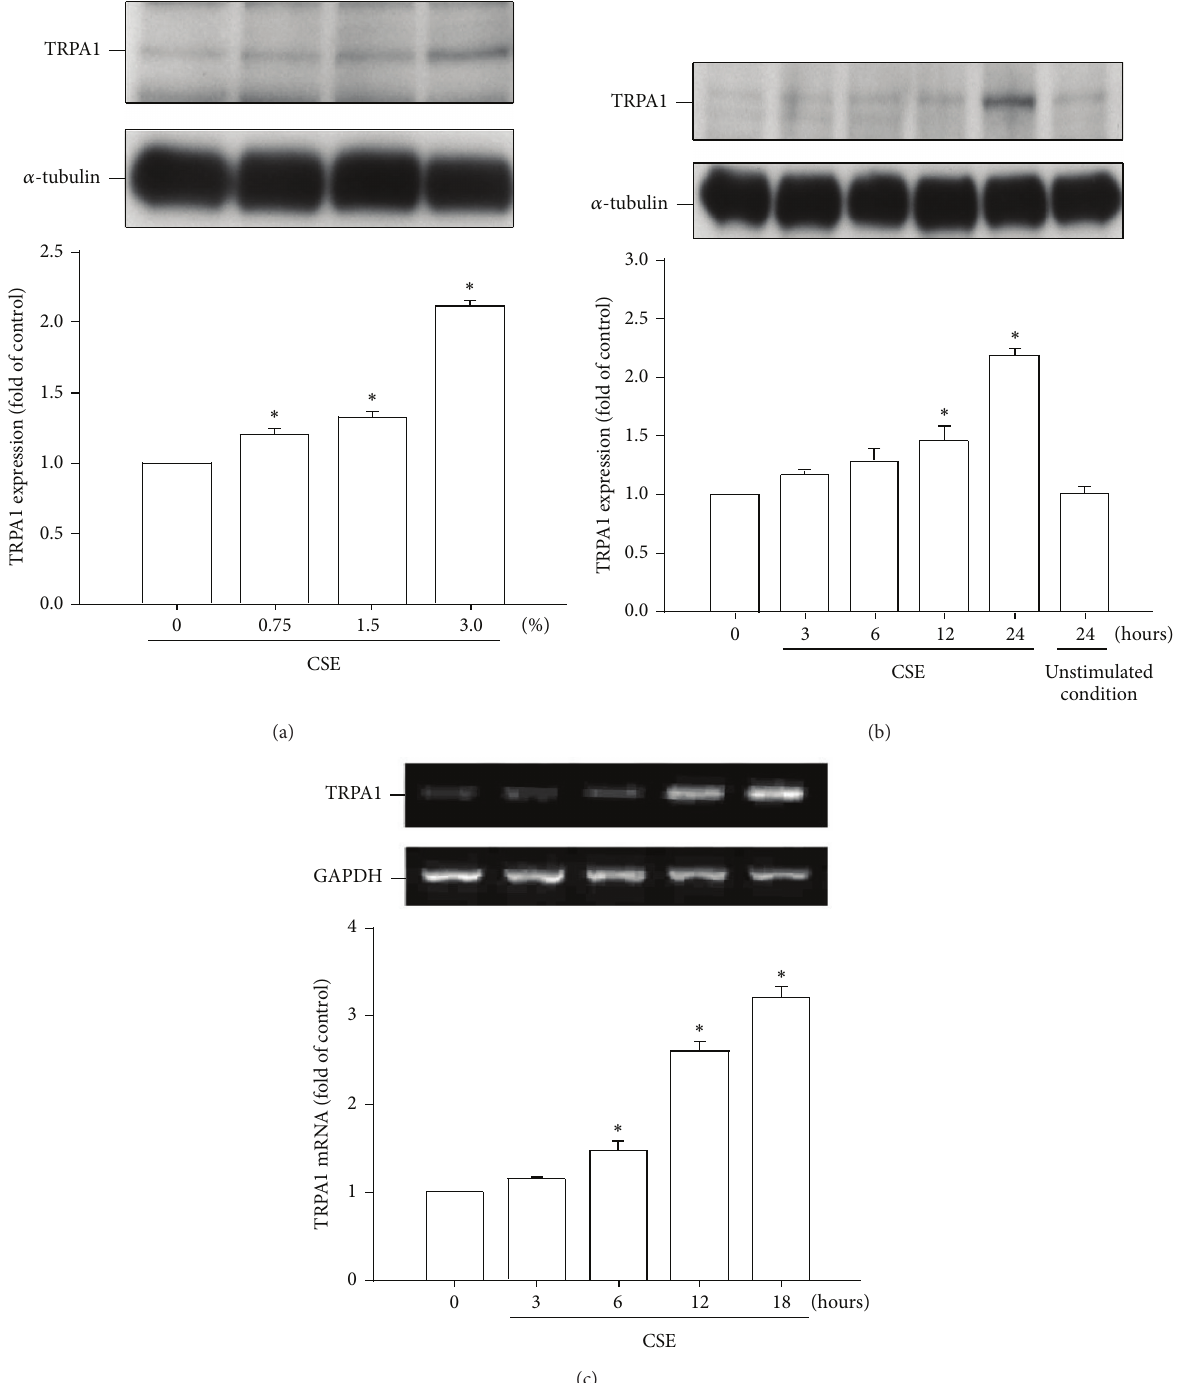
Figure 1: Cigarette smoke extract (CSE) concentration-dependently and time-dependently increases TRPA1 expression in human bronchial epithelial cells (HBECs). (a) Cells were exposed to 0–3% CSE for 24 hours. (b) Cells were incubated with medium alone at time 0 and for 24 hours or exposed to 3% CSE for the indicated times. (c) Cells were exposed to medium alone or exposed to 3% CSE for indicated times. Protein (a and b) and mRNA (c) levels in the cell lysates were analyzed by Western blotting and RT-PCR, respectively. The data in each group are mean ± SEM from five independent experiments. ∗ 𝑝 < 0.05 versus the control or versus time